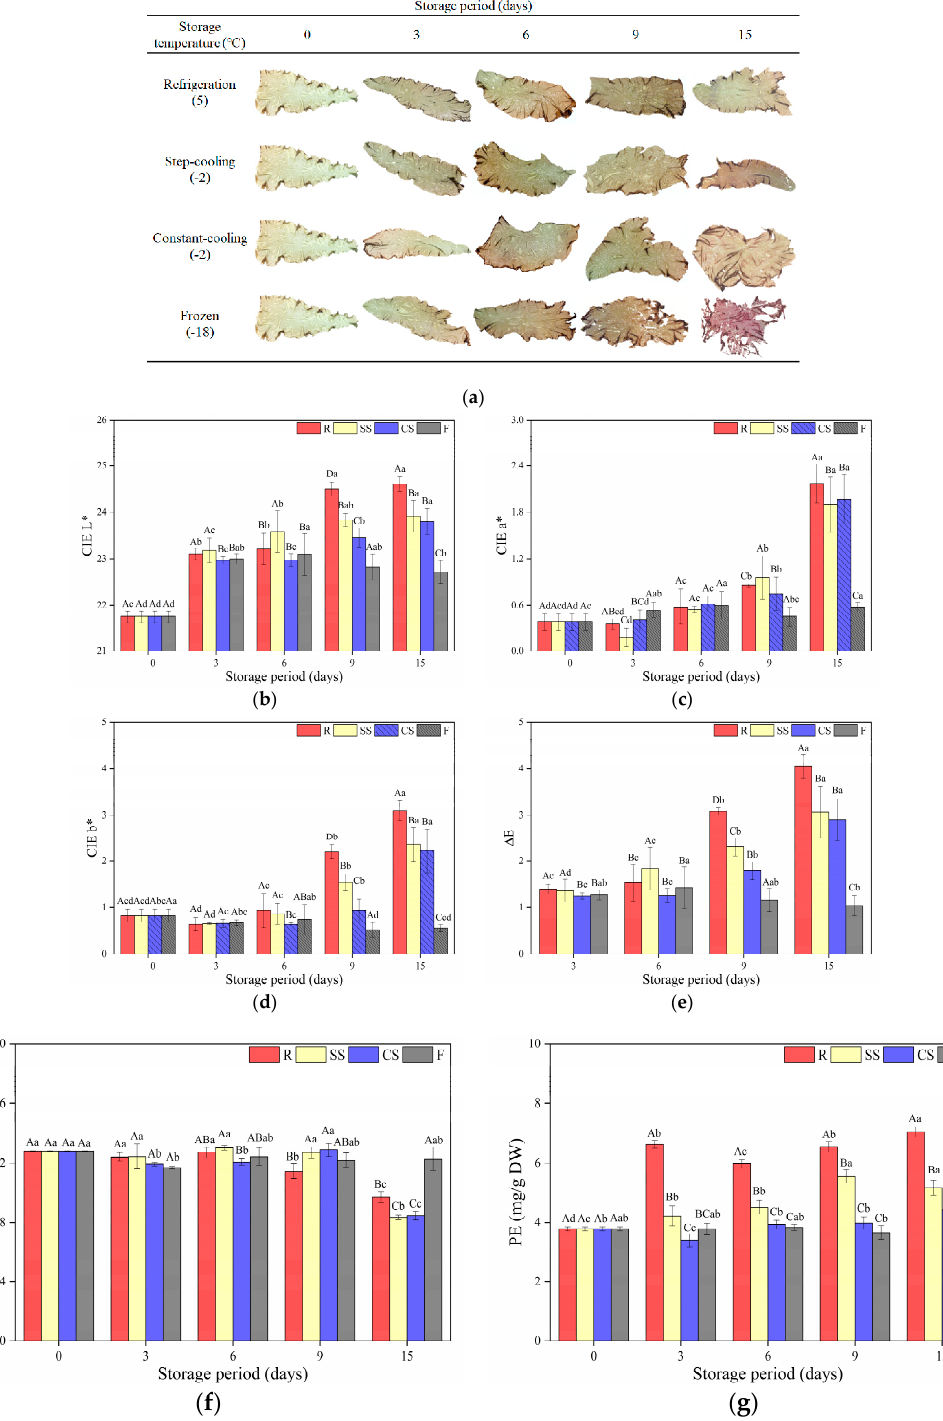
Figure 3. Changes in ( a ) the appearance of laver, ( b ) CIE L*, ( c ) CIE a*, ( d ) CIE b*, ( e ) total color difference, ( f ) chlorophyll-a ( Chl-a ) and ( g ) phycoerythrin ( PE ) of raw laver ( Pyropia yenzoensis ) depending on various storage methods and periods. R, refrigeration; SS, supercooling by stepwise cooling algorithm; CS, constant temperature supercooling; F, freezing. A–D Means with different letters within the same storage period are significantly different ( p < 0.05). a–d Means with different letters within the same storage temperature are significantly different ( p < 0.05).